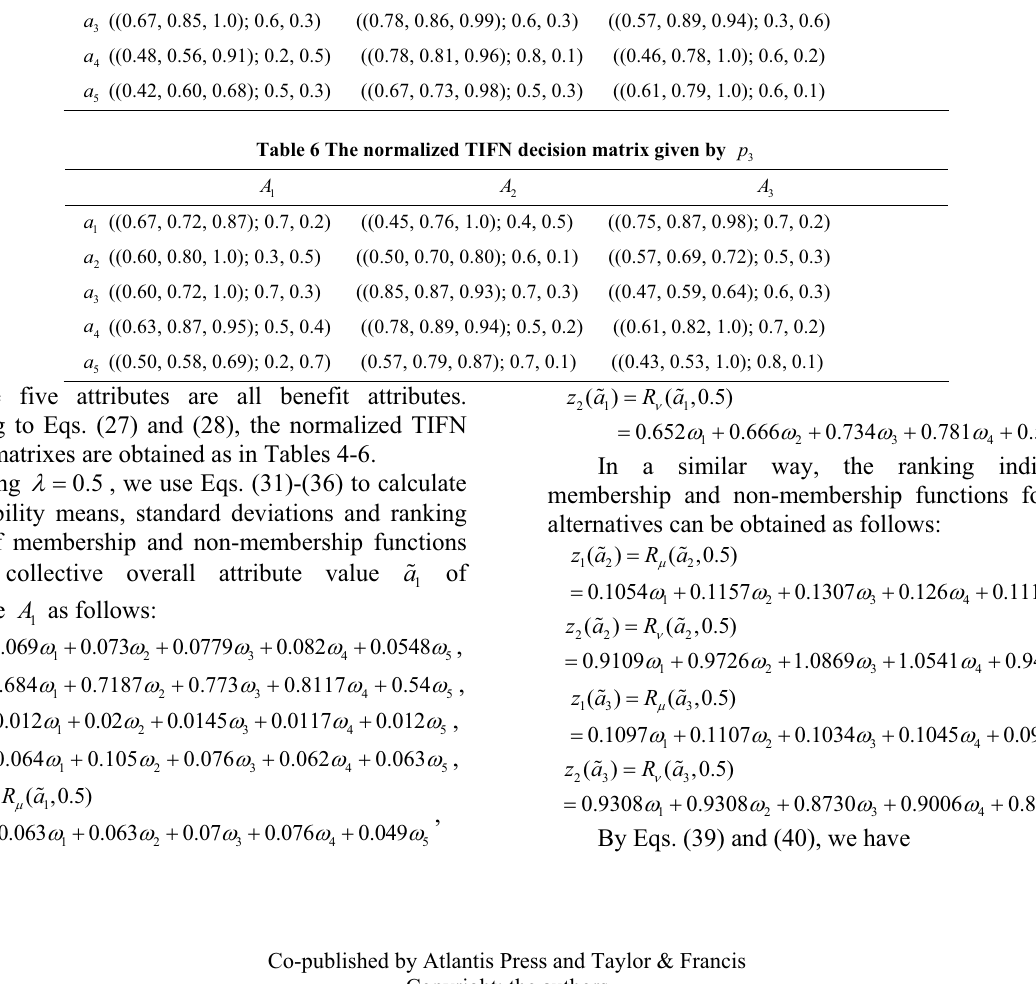
Table 5 The normalized TIFN decision matrix given by